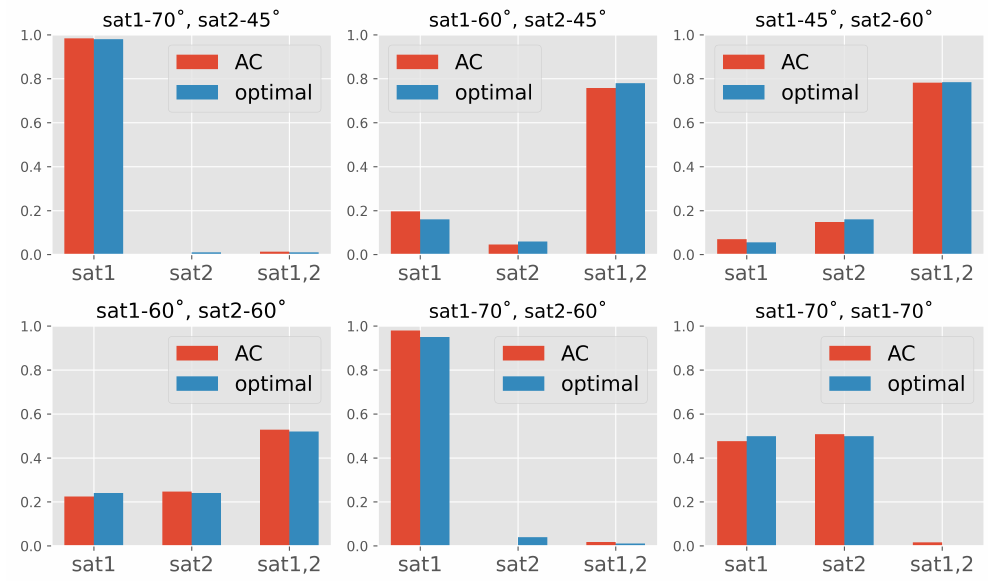
Figure 6. Categorical distribution for multi-link scheduling with AC vs. optimal scheduling at different elevation angle PLRs! ( PLRs! ) (good = 0, bad = 1).